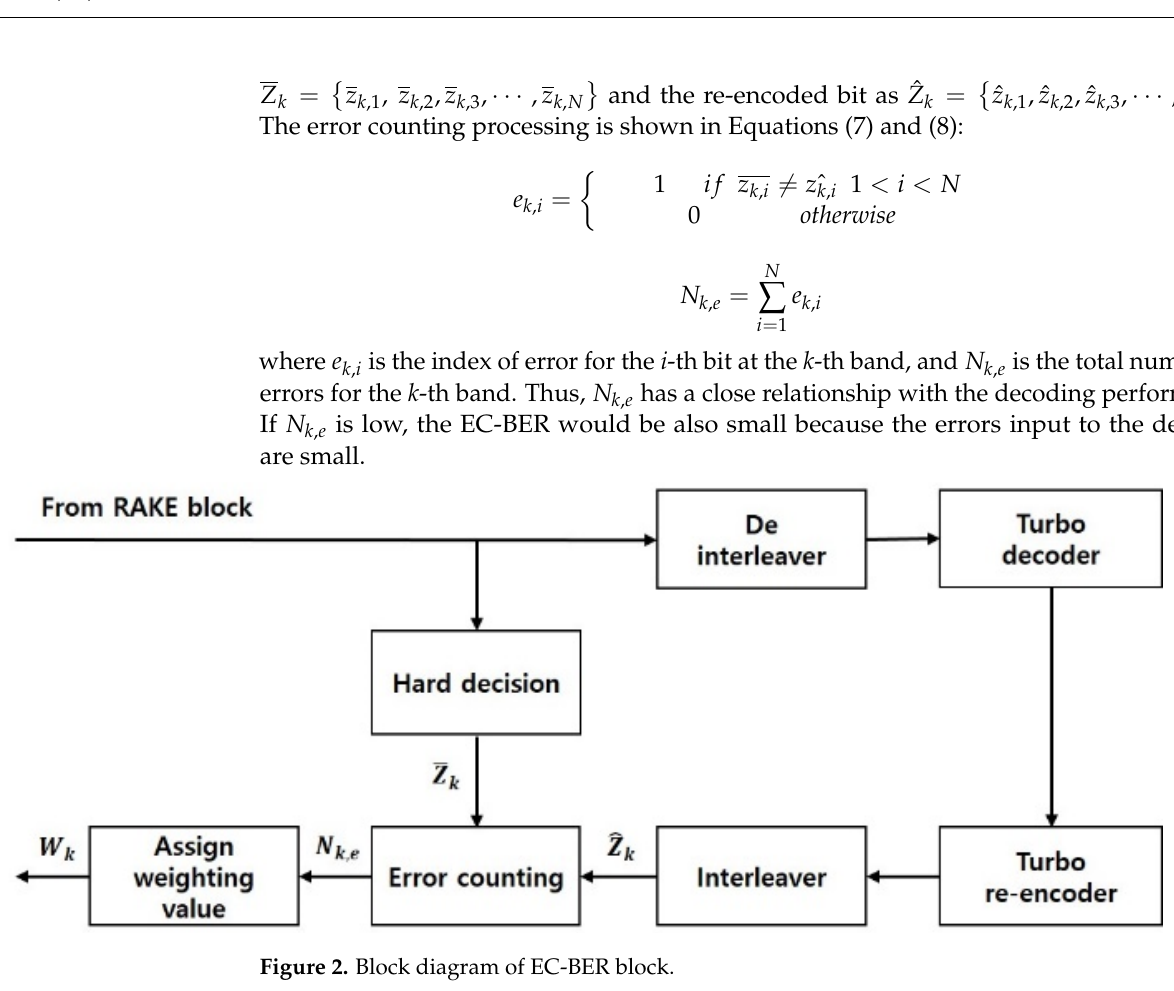
Figure 2. Block diagram of EC-BER block.